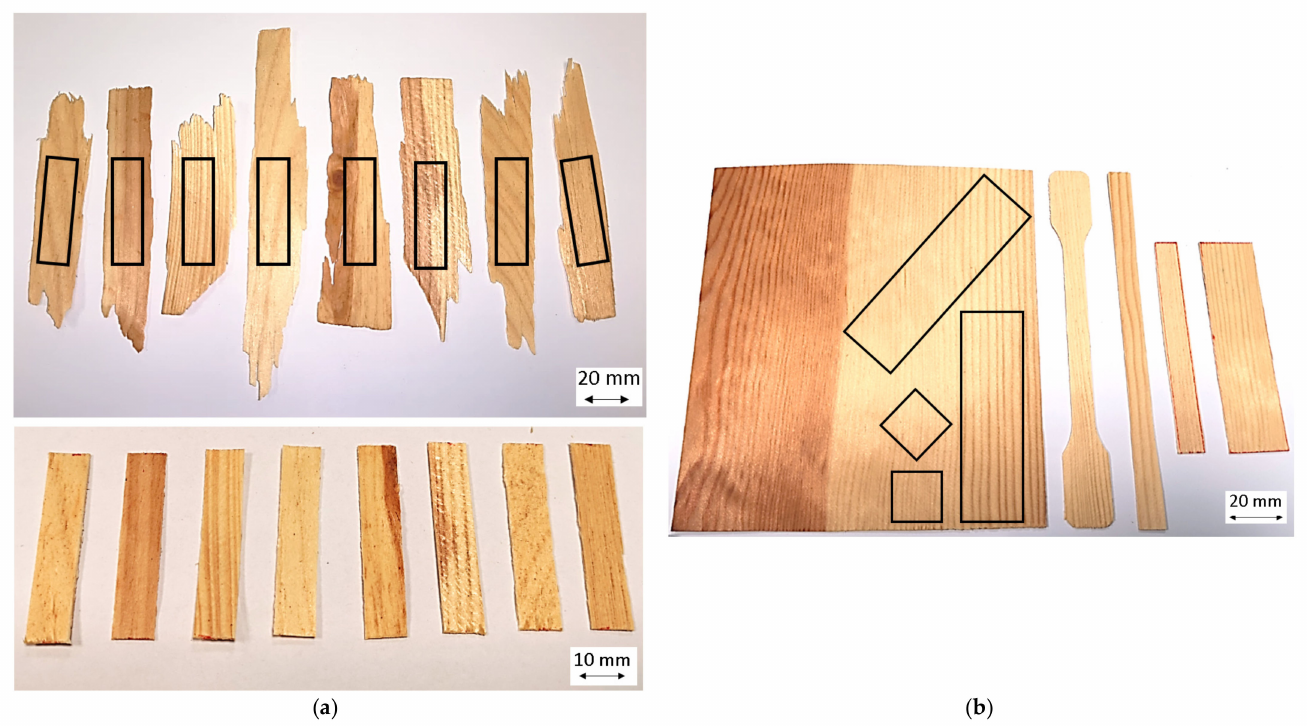
Figure 10. OSB strands and specimens taken therefrom using a punch ( a ) and pine veneer used and utilized specimen shapes ( b